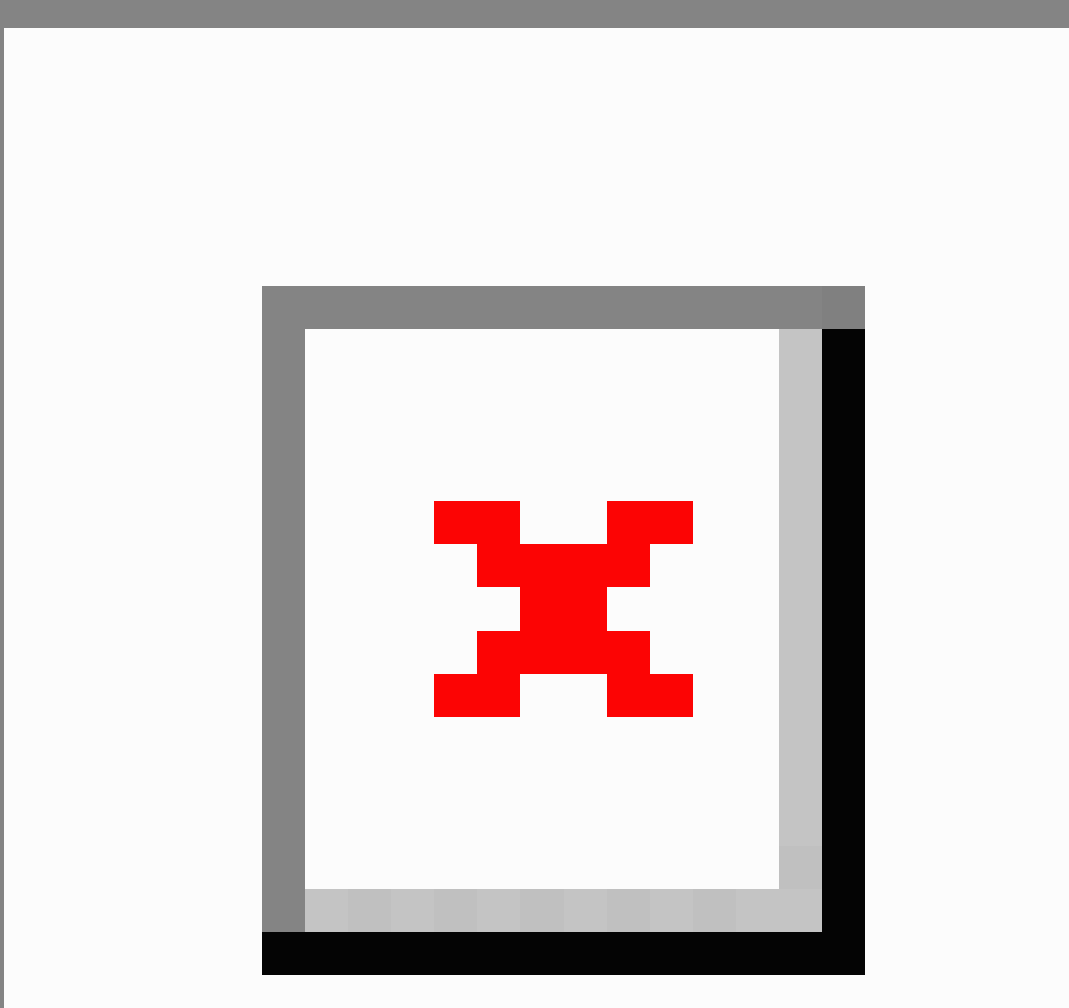
Figure 2. Lens simulation of smartphone-based endoscope system. (a) Ray-tracing of optics for smartphone-based endoscope system. d e denotes a diameter of the eyepiece of endoscope probe, which is the image source. Achromatic lens (L1) having f=40 mm, Ø25.4 mm and aspherized achromatic lens (L2) having f=14 mm, Ø12.7 mm were utilized. Smartphone lens (L3) was simulated to deliver the image to complementary metal-oxide semiconductor sensor. (b) Schematic of assembled lens system in smartphone-based endoscope